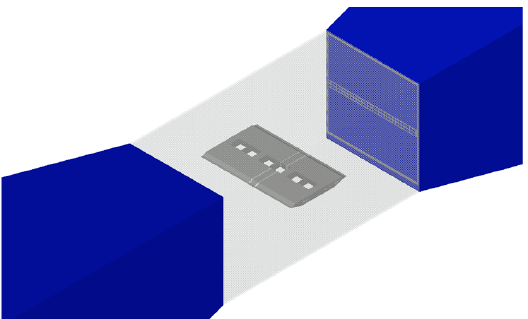
Figure 4. Sketch view of the section model in the test section and the body-height grid in the flow inlet.